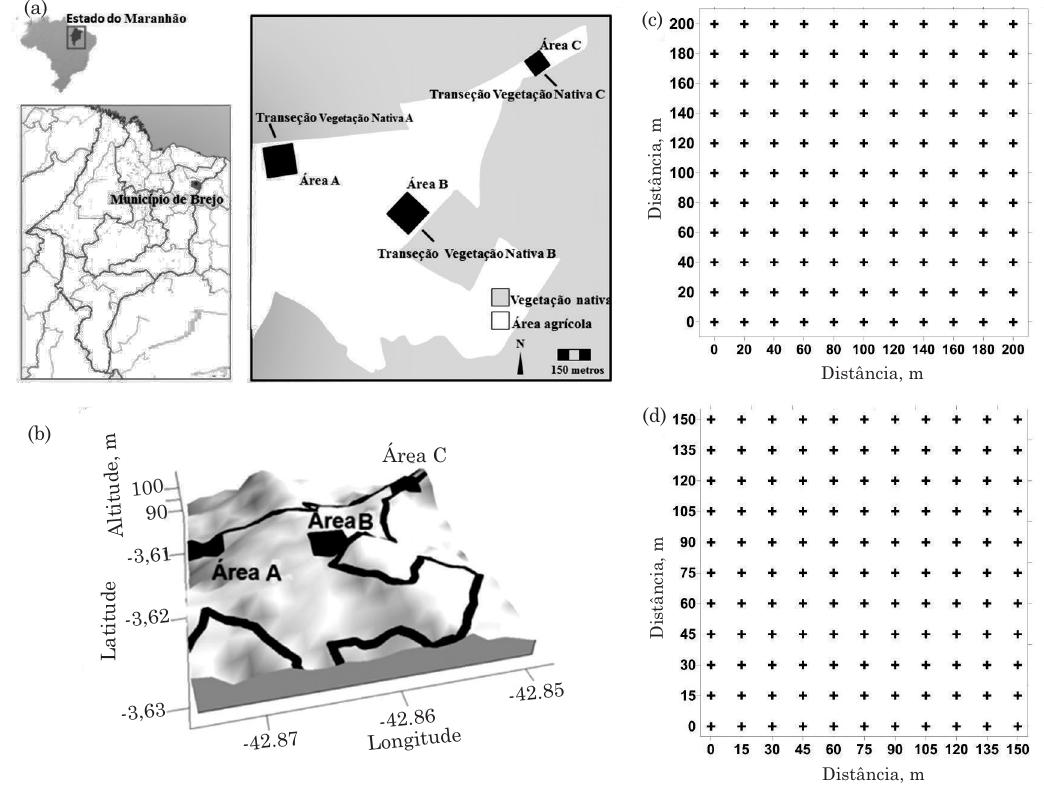
Figura 1. Localização da área: malhas de amostragem e transeções (a); modelo digital de elevação (b); malha amostral utilizada para as áreas A e B (c); e malha amostral utilizada para a área C